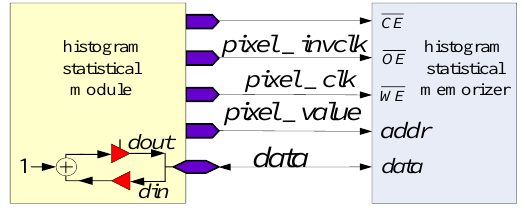
Figure 5. Statistical module diagram of gray level